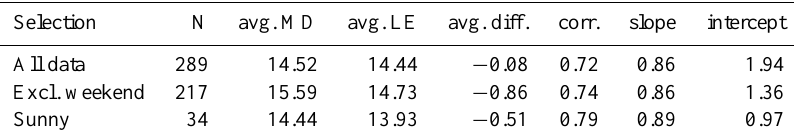
Table 3. Comparison of 1h averages of tropospheric NO 2 columns from MAX-DOAS (MD) and Lotos-Euros (LE). σ diff denotes the standard deviation of the Gaussian fit to the differences between MD and LE; see Fig. 6. Columns 3, 4, 5, 8 and 9 are in 10 15 moleccm − 2 . Selection N avg. MD avg. LE avg. diff. corr. slope intercept σ diff All data 2106 Cloud covered 190 Partially cloudy Sunny Table 4. Comparison of daily averages of tropospheric NO 2 columns from MD and LE. Only days with at least 5h of data were used. Columns 3, 4, 5 and 8 are in 10 15 moleccm − 2 . Selection N avg. MD avg. LE All